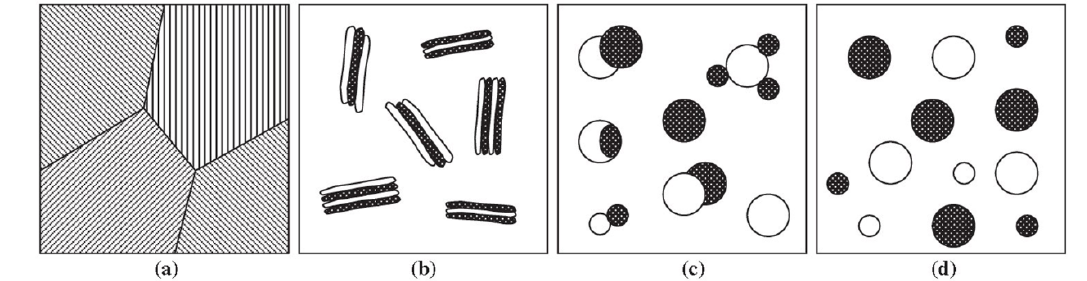
Figure 23. Diagram showing the effect of forced convection during eutectic solidification on the morphology of eutectic phases in binary alloys: ( a ) without forced convection, ( b ) low intensity of forced convection, ( c ) moderate intensity of forced convection, and ( d ) high intensity of forced convection [218]. Reprinted under the Creative Commons Attribution License (CC-BY) 4.0.